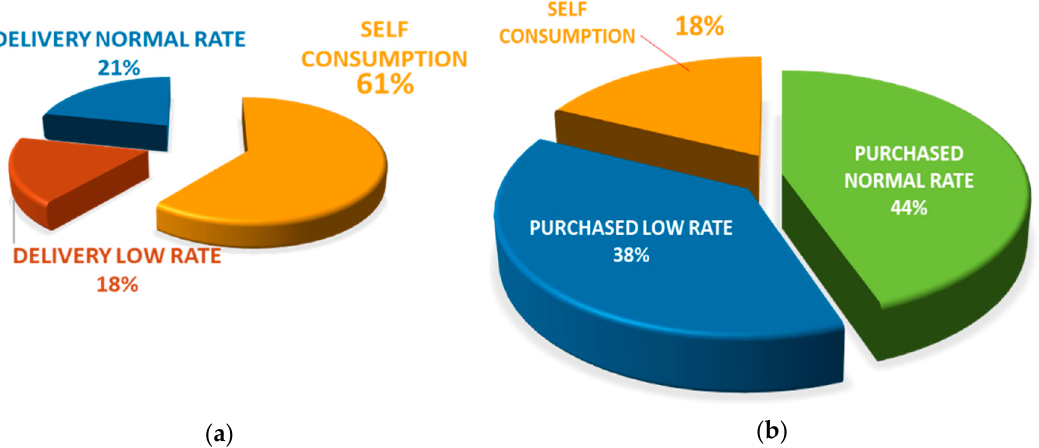
Figure 2. PowerMatching City electricity purchase, self-consumption, and production in 2012: ( a ) Electricity generated by PV and µ CHP; percentages of self-consumption and electricity delivery depending rates; ( b ) Self consumption and electricity purchased from the grid, with purchase percentages depending on rates.